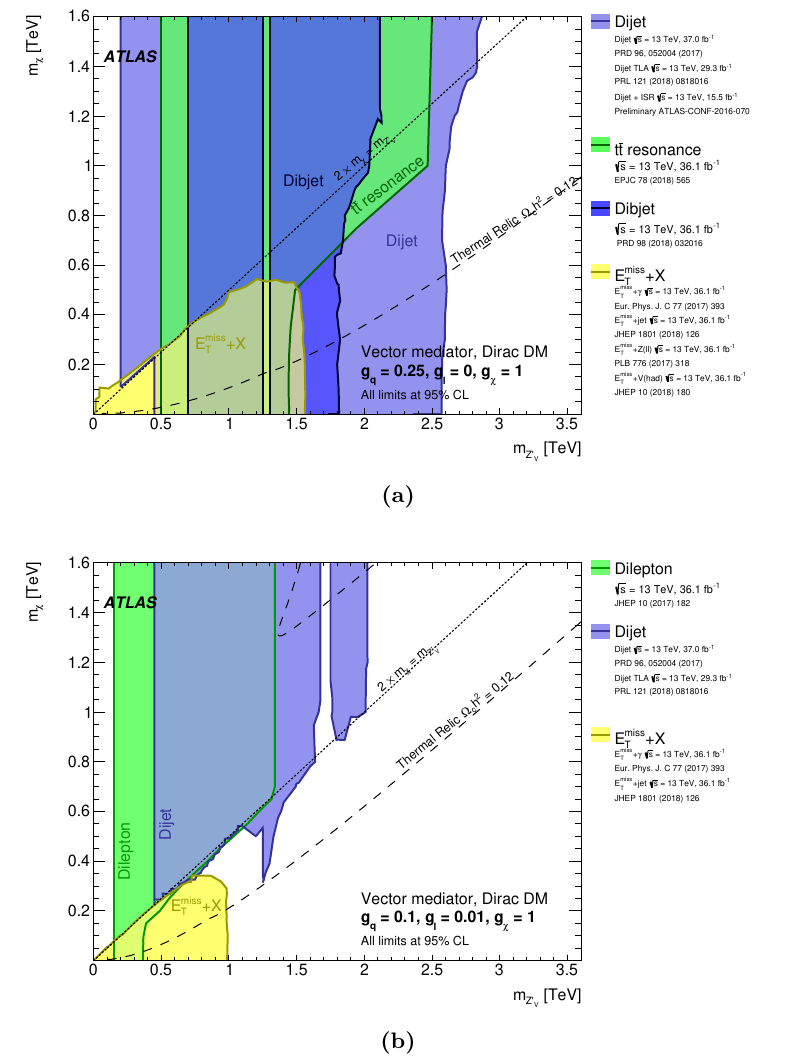
Figure 11. Regions in a (mediator-mass, DM-mass) plane excluded at 95% CL by dijet, dilepton and E miss + X searches, for leptophobic (a) or leptophilic (b) vector mediator simpli(cid:12)ed models T described in section 2.1.1. The exclusions are computed for a DM coupling g (cid:31) , quark coupling g q , universal to all (cid:13)avours, and lepton coupling g ‘ as indicated in each case. Dashed curves labelled \thermal relic" correspond to combinations of DM and mediator mass values that are consistent with a DM density of (cid:10) h 2 = 0 : 12 and a standard thermal history as computed in MadDM [77, 204]. Above the curve in (a) annihilation processes described by the simpli(cid:12)ed model deplete (cid:10) h 2 to below 0 : 12. In (b), this occurs between the two dashed curves. The dotted line indicates the kinematic threshold where the mediator can decay on-shell into DM.